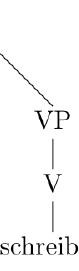
Figure 17. Elementary tree without V extraposition